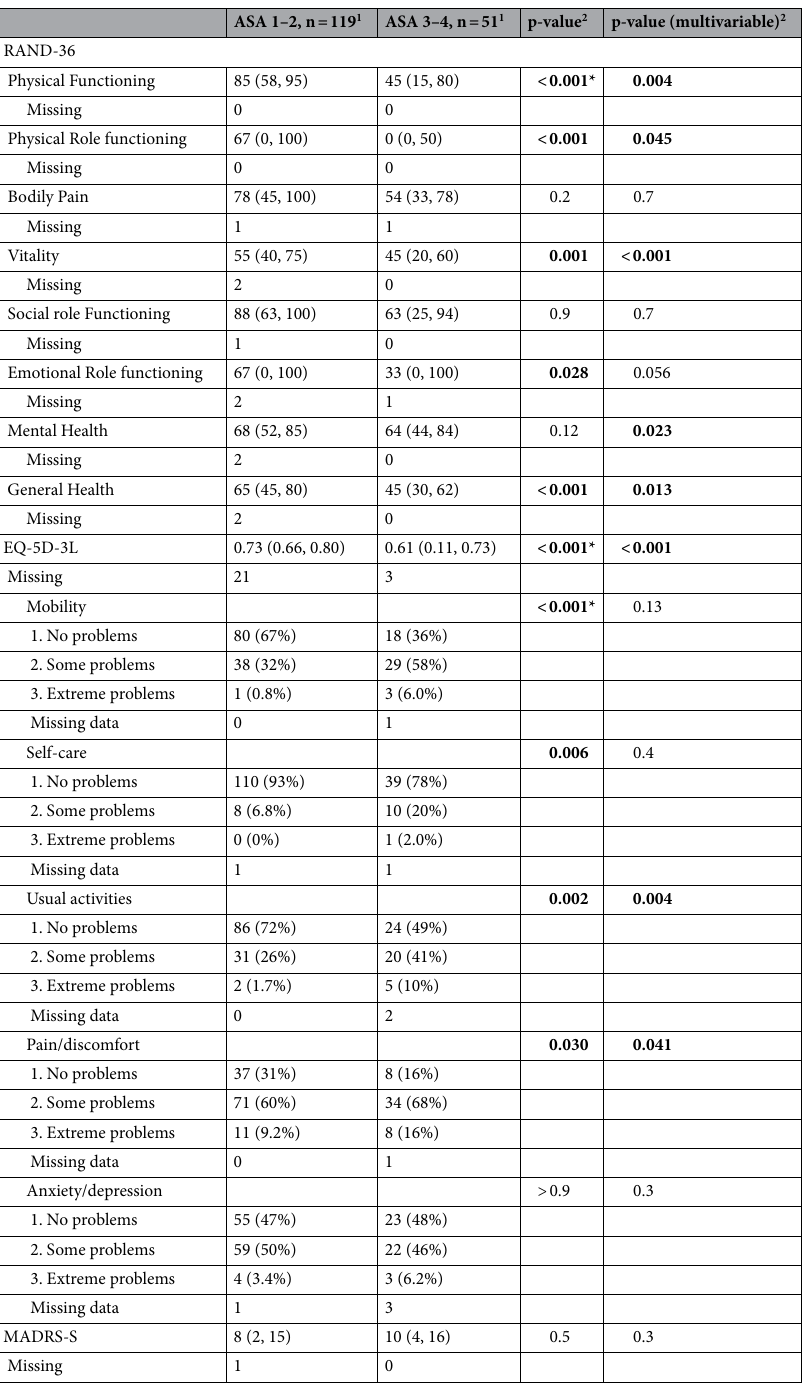
Table 4. Results ASA. Comparing health-related quality of life (HRQoL), assessed with RAND-36 and EQ-5D, and symptoms of depression assessed with Montgomery Åsberg depression Rating Scale self-report (MADRS-S), in TBI patients with ASA 1–2 to TBI patients with ASA 3. 1. n (%); Median (IQR), 2. Ordered logit. Significant values are in bold. *Significant after Bonferroni